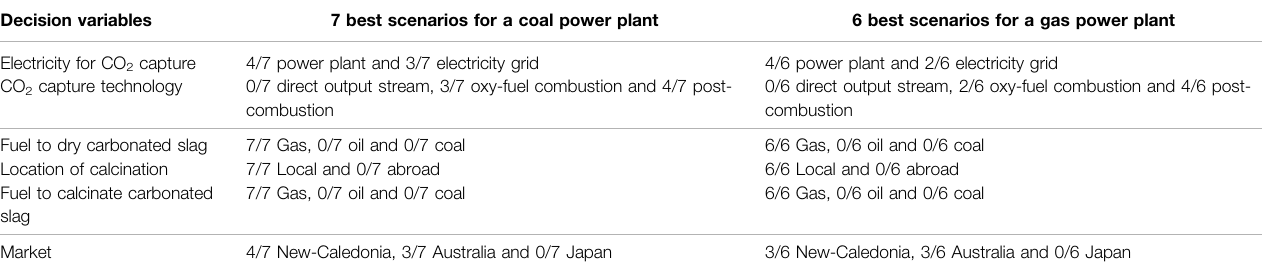
TABLE 5 | Best 13 scenarios options of the nickel slag valorization sector at the 2035 production time-horizon. Decision